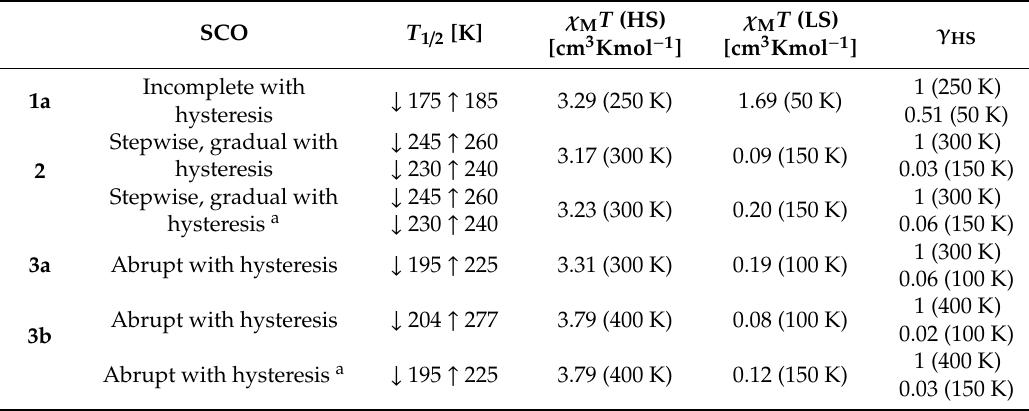
Figure 3. Plots of the χ M T product vs. T for compounds 1a , 2 , 3a , and 3b . Black squares represent the first cooling and heating cycle and red circles correspond to the cooling and heating cycle after annealing. Table 4. Overview of magnetic properties, T 1 / 2 values, values of the χ M T product and the corresponding temperatures, and HS residues of the synthesized compounds. SCO: spin